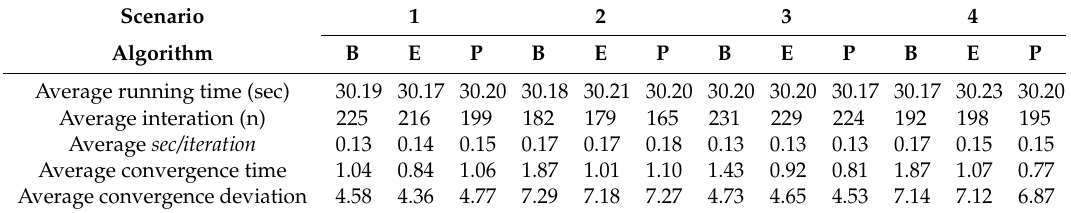
Table 6. Performance evaluation results of basic PID, existing, and proposed